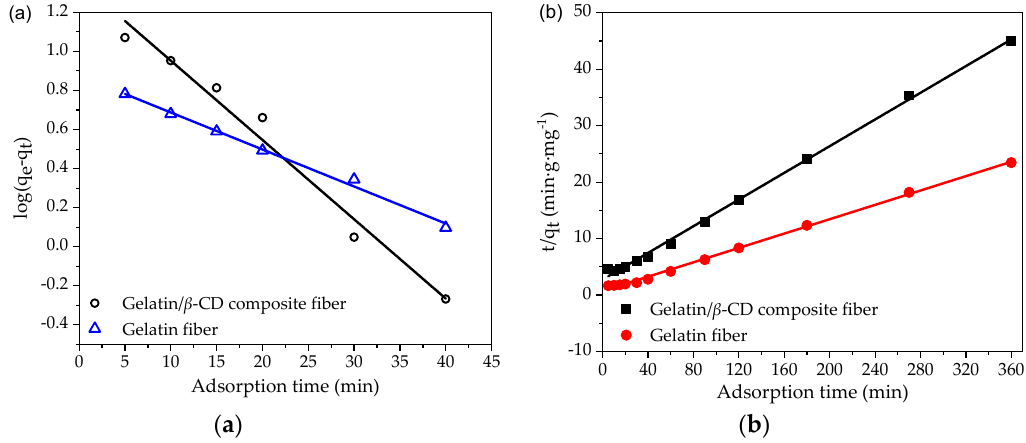
Figure 4. Kinetics of methylene blue (MB) adsorption onto gelatin and gelatin/ β -CD composite fiber adsorbents.